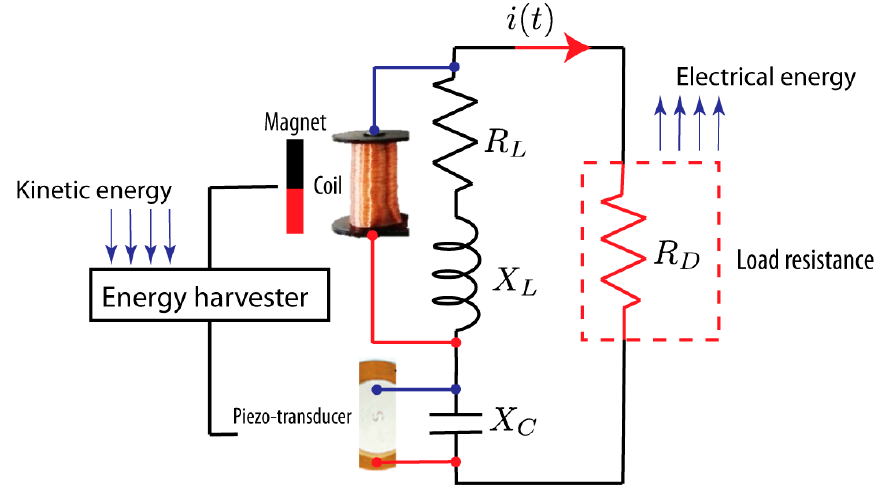
Figure 1. Schematic representation of the piezo-inductive device with the load resistance.